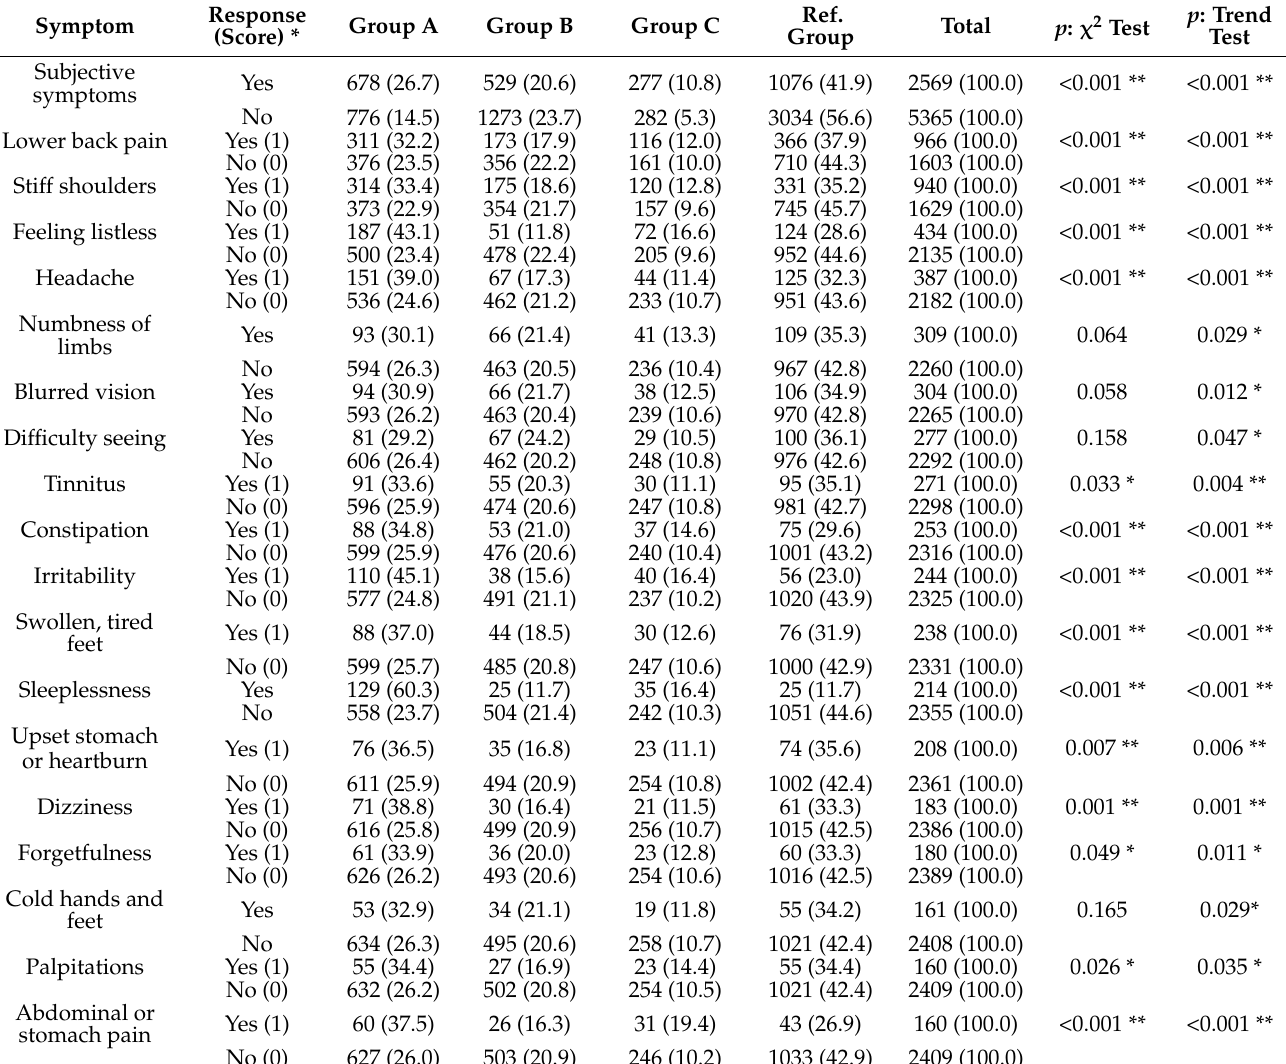
Table 3. Comparison of subjective symptoms by sleep